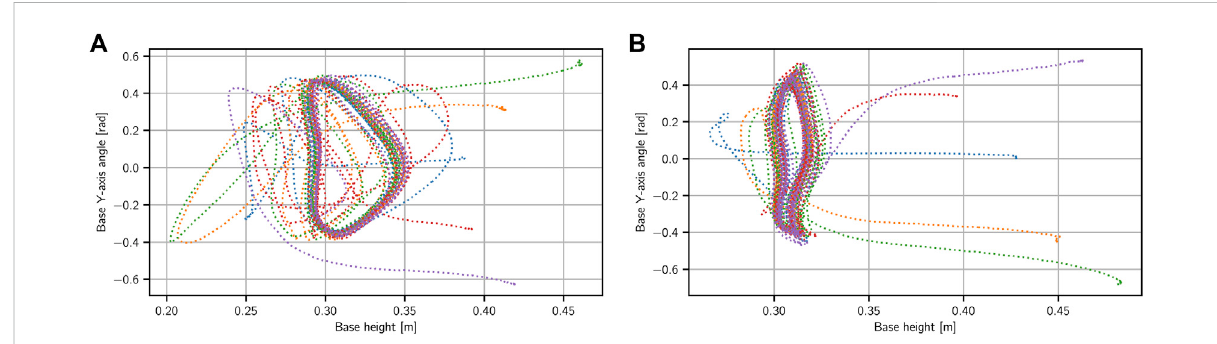
FIGURE 5 Two different bounding behaviors on the robot with different initial conditions. Starting with a wide range of initial angles for the base in y -direction (roughly between − 35 and 35 deg), the robot quickly converges back to the desired